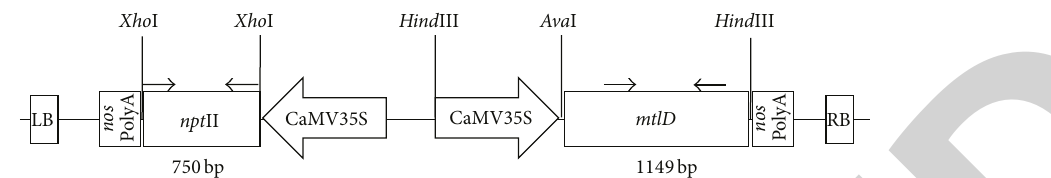
Figure 1: Schematic representation of the T-DNA region of pCAMBIA 1380 binary plasmid used for transformation of deembryonated cotyledons with Agrobacterium tumefaciens strain LBA 4404. The position of the primers used in PCR assays is shown by arrows on top of the mtlD gene. LB, left T-DNA border sequence; RB, right border sequence; 35S, CaMV35S promoter; and mtlD , mannitol-1-phosphate